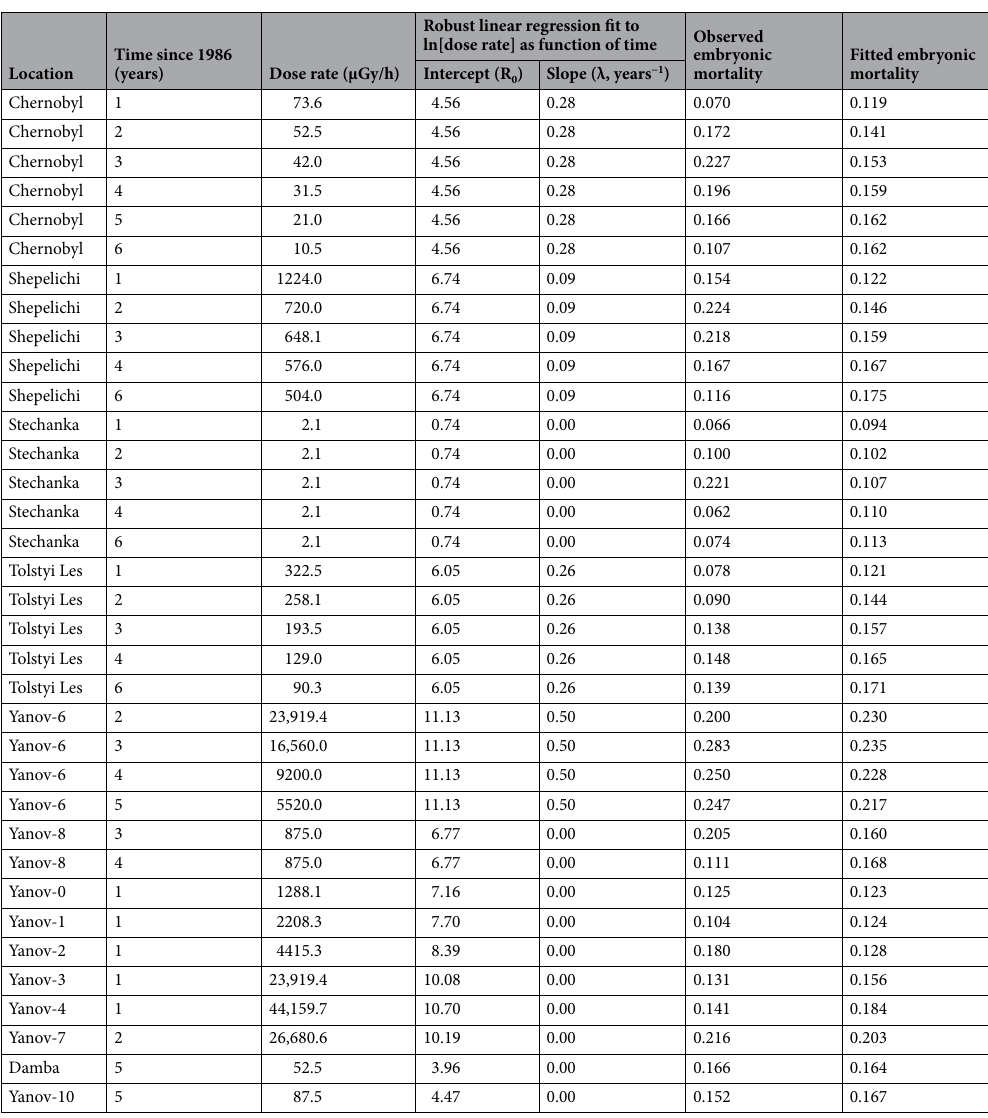
Table 1. Comparison of observed and fitted embryonic mortality in the plant data set. R 2 for observed versus model-fitted values was 0.43, and RMSE was